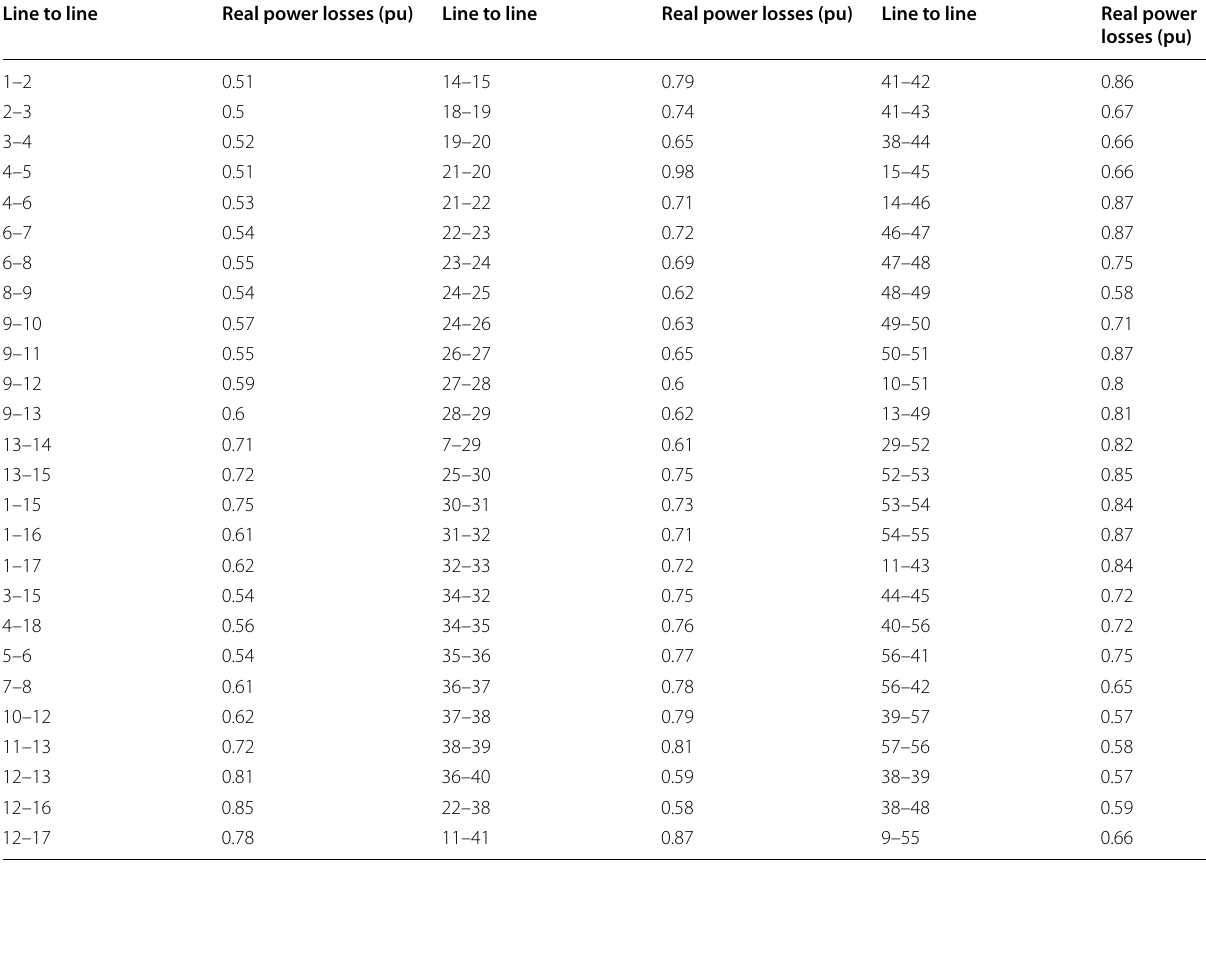
Table 4 Real power estimation of standard IEEE-57 bus system using heuristic pdf